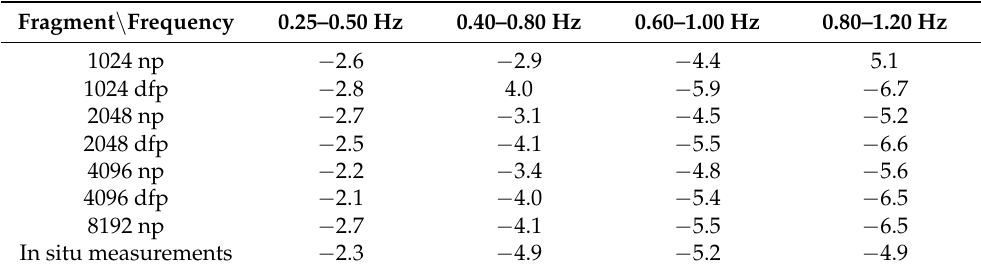
Table 4. Coefficients of the power-law decay of the spectra for different fragments and fre- quency